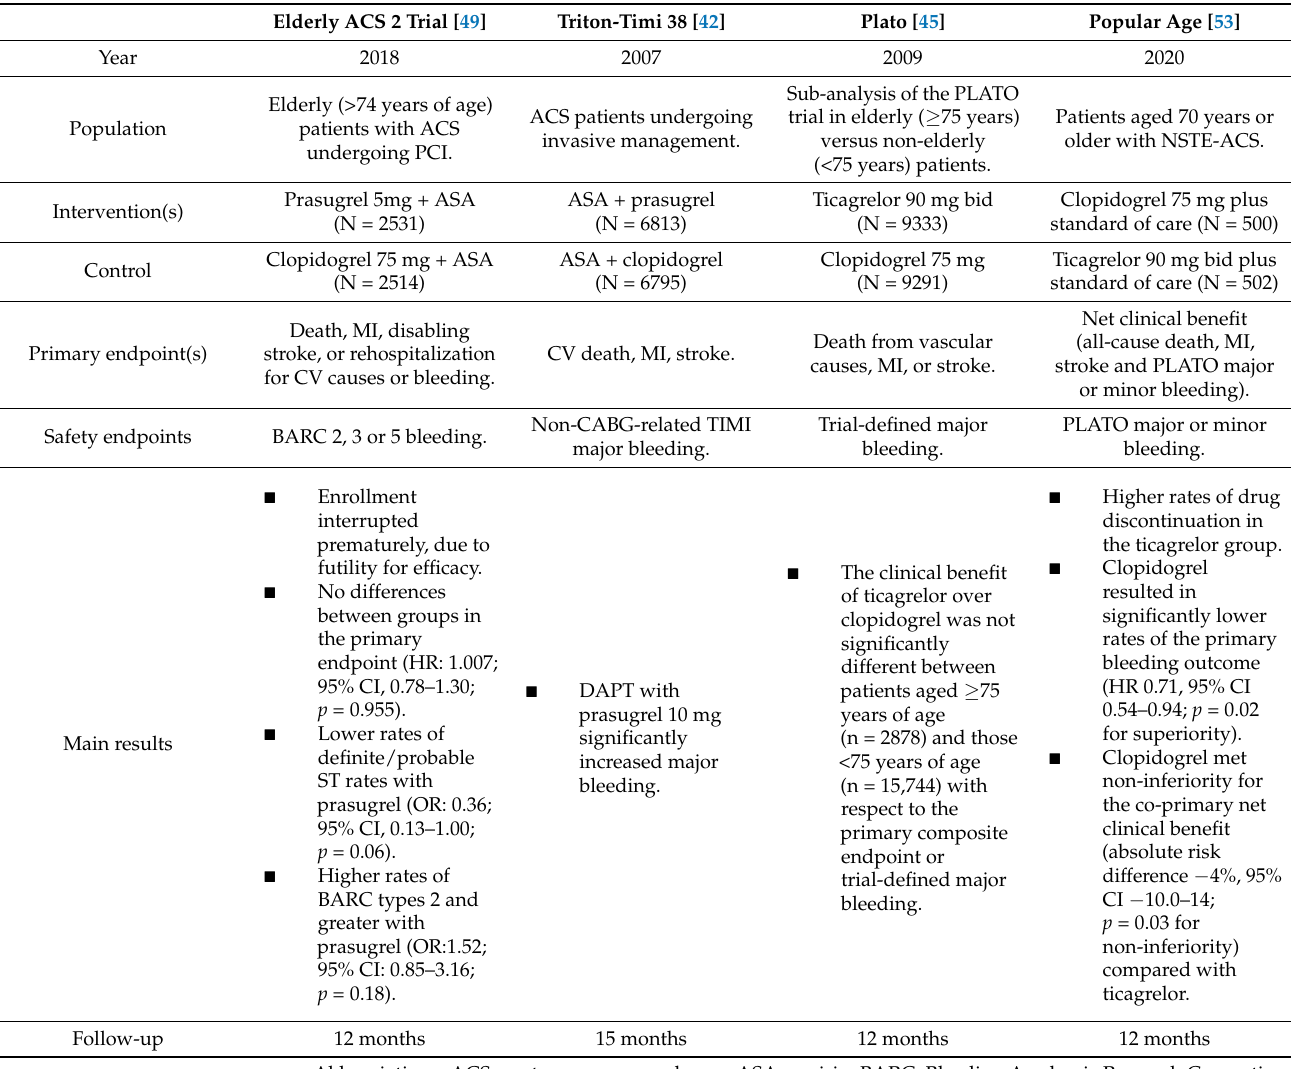
Table 2. Key contemporary randomized trials on DAPT with different P2Y 12 inhibitors among elderly patients with ACS.